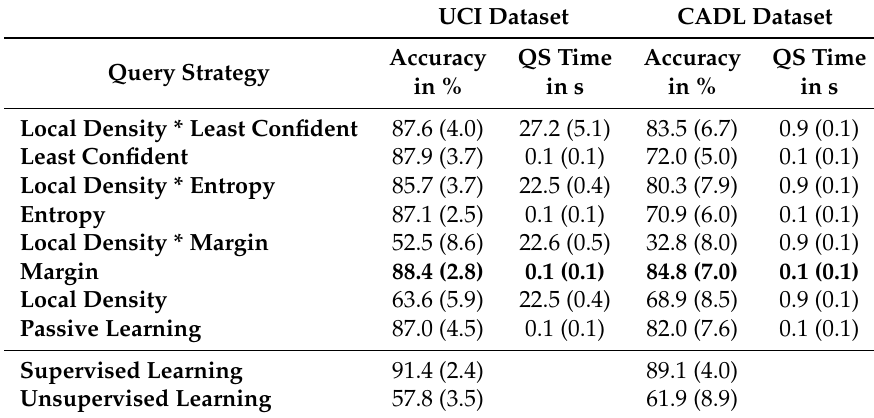
Table 3. Experimental results for the Query Strategies in terms of: classifier’s accuracy and the QS algorithm’s execution time. For all listed values it is shown its 10-fold CV average and standard deviation, the latter between parenthesis. The best performing algorithm is shown in bold for each